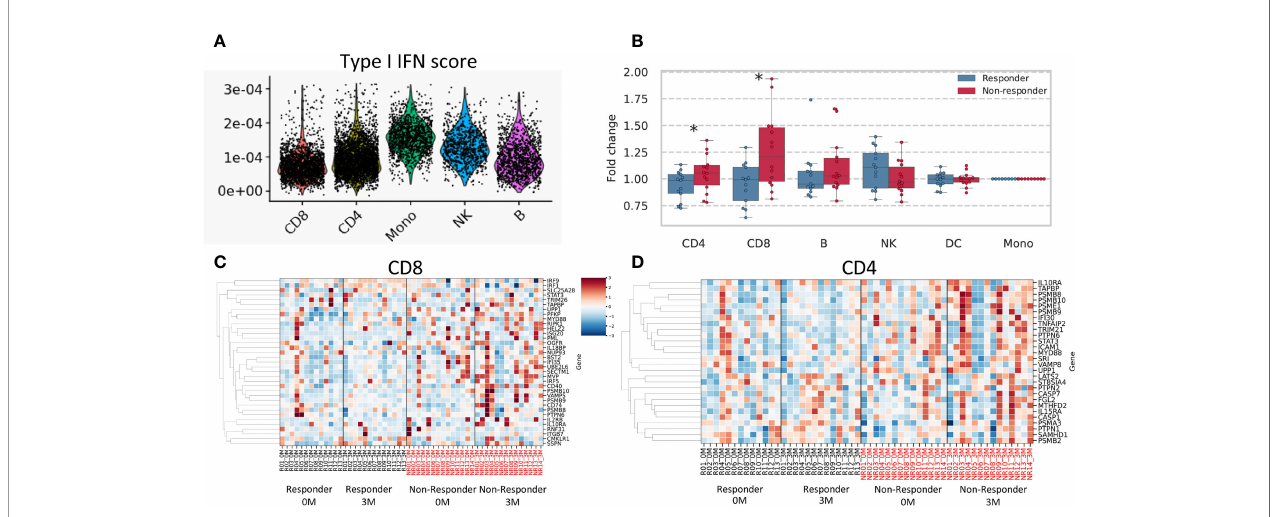
FIGURE 6 | Results of single-cell data and a deconvolution analysis of the IFN signature. (A) Type I IFN scores for each cell subtype are shown. (B) Fold changes (after/before treatment) in the mean expression of type II IFN-related genes are shown according to each cell subtype. A heatmap of estimated expression in cells positive for CD8 (C) and CD4 (D) . The estimated expression of each gene was standardized across all samples, and Z scores were shown. * stands for p < 0.05 by the Mann-Whitney U test. CD4, CD4-positive cells; CD8, CD8-positive cells; B, B cells; DC, Dendritic cells; NK, Natural killer cells.